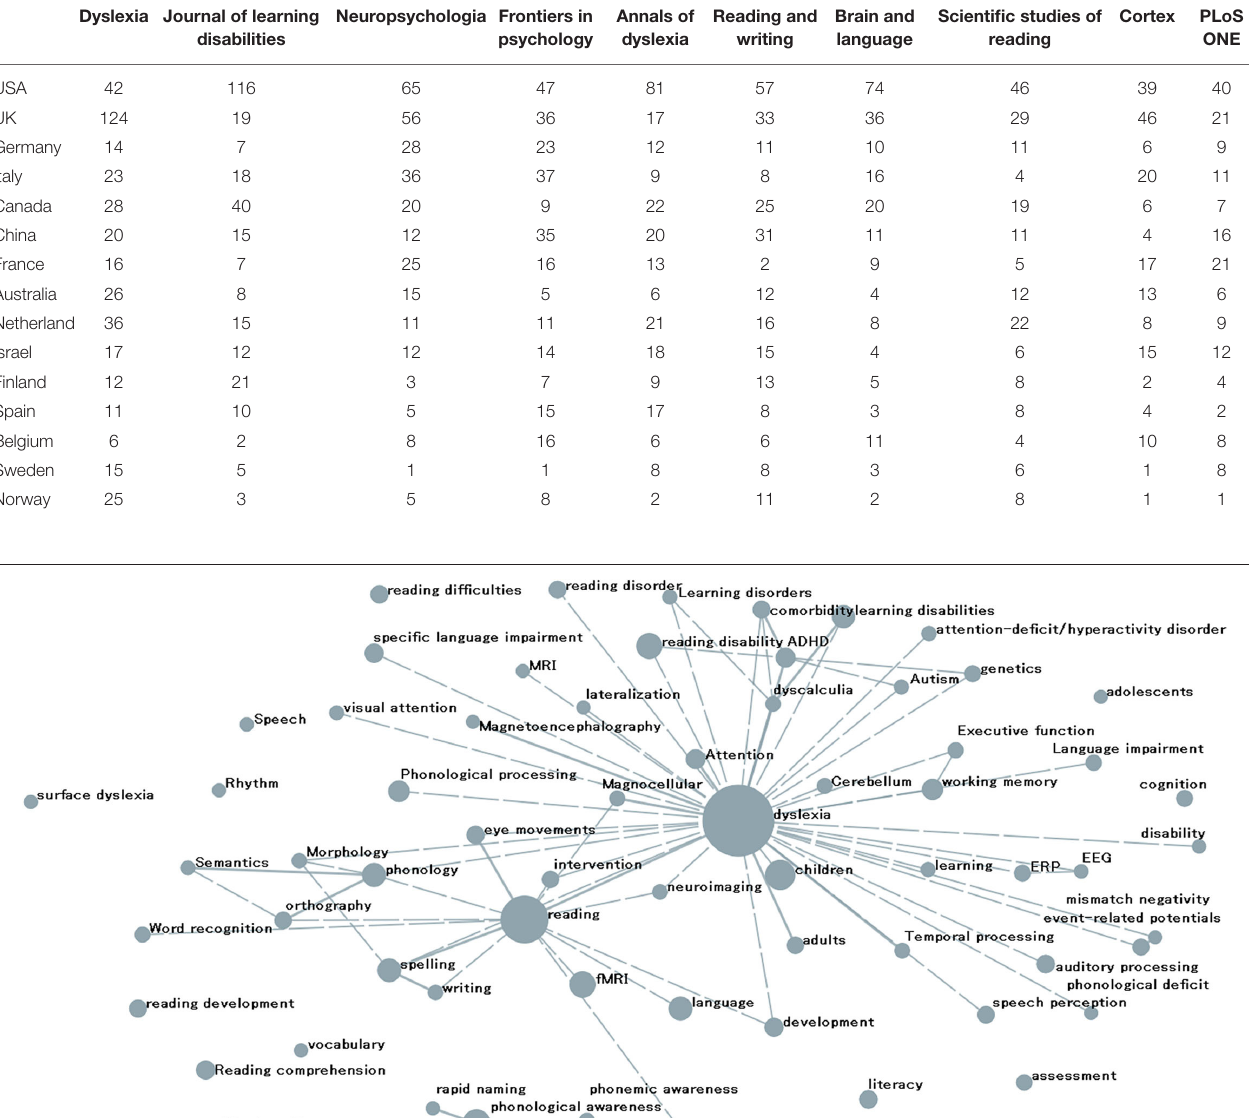
TABLE 3 | Number of papers in the top 10 Journals and by the top 15 most productive countries.